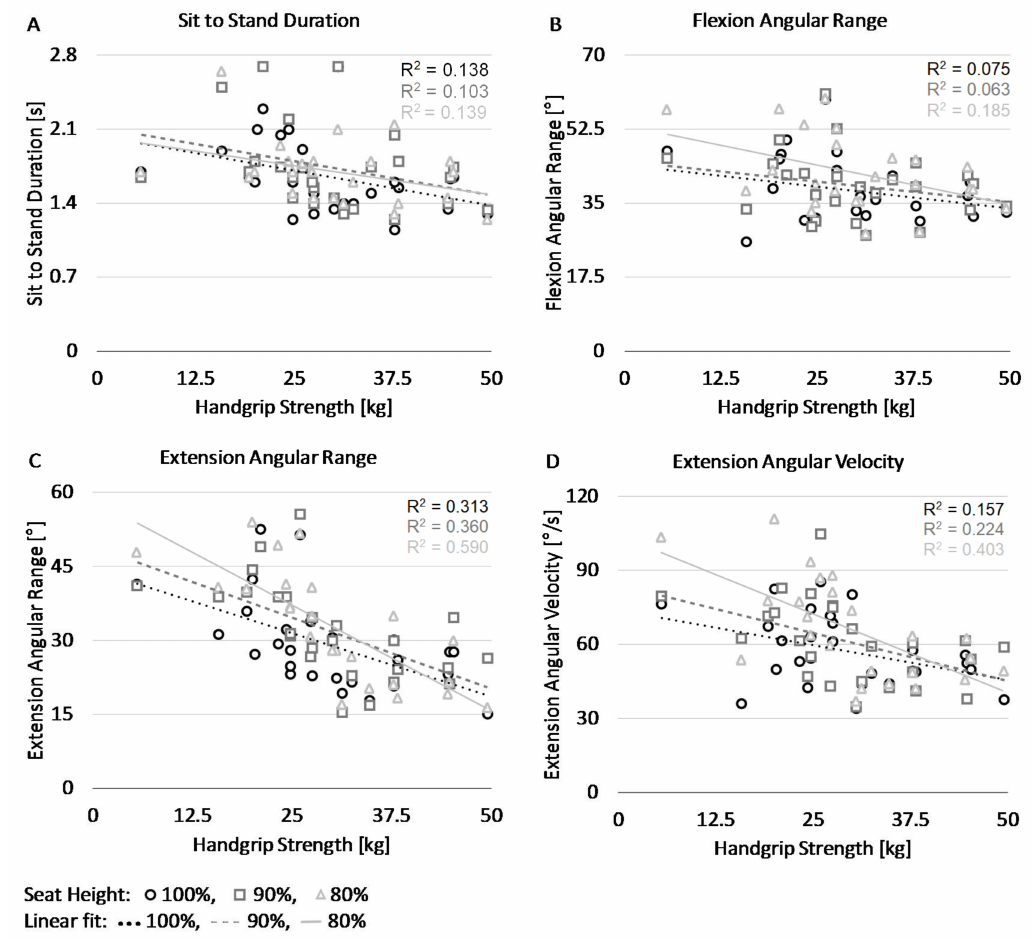
Figure 3. Scatter plots display values of the four STS parameters and handgrip strength at three different seat heights. Panel ( A ) shows the total duration of the SiSt phase. Panel ( B ) shows the angular range during the STS flexion phase. Panel ( C ) shows the angular range during the STS extension phase. Panel ( D ) shows the maximal angular velocity during the STS extension